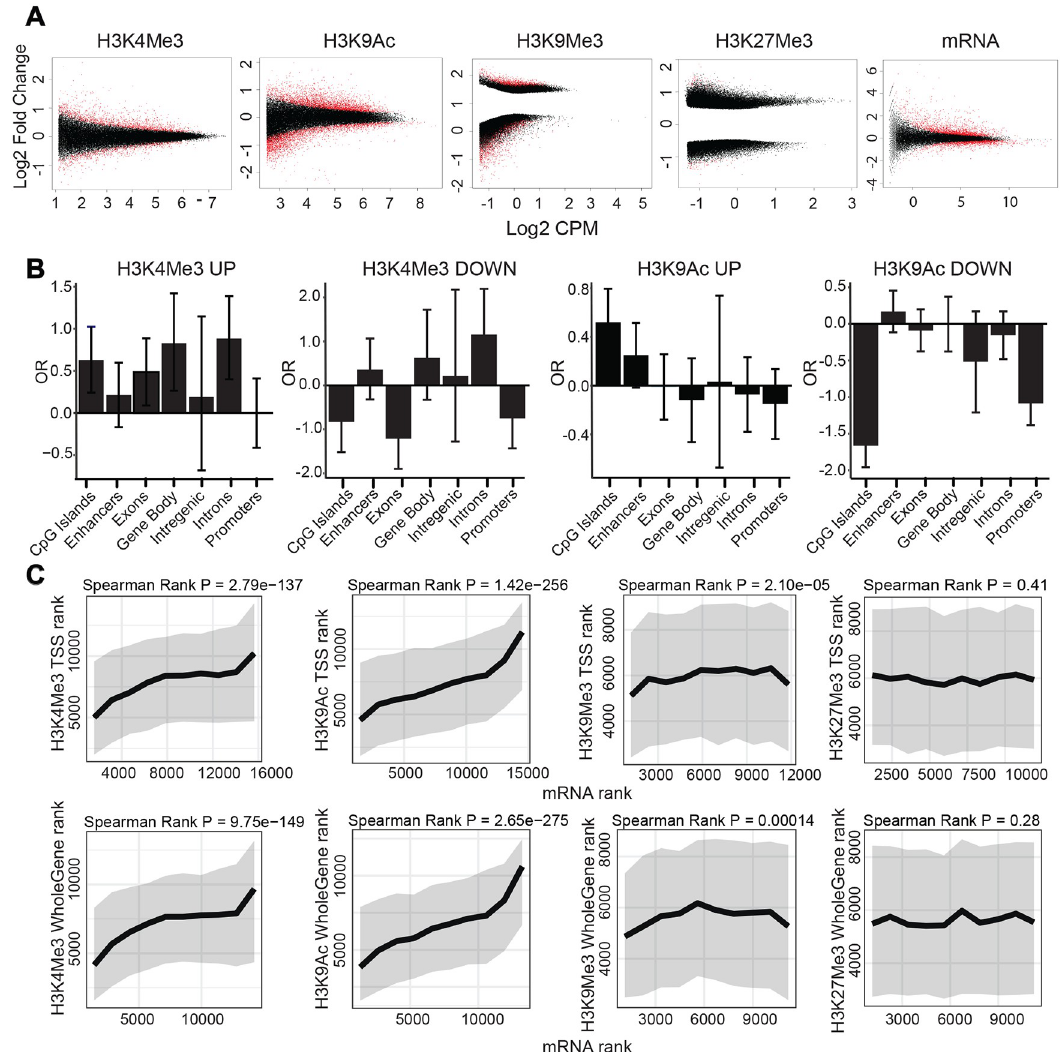
Fig 1. Differential genome-wide distribution of epigenetic markers between HCV infected vs. non-infected cells and its integration with gene expression. (A) Change in genome-wide distribution of epigenetic marks following HCV infection (100% HCV infected Huh7.5 cells, generated as described in the Methods) determined by ChIP-seq experiments, as well as change in gene expression determined by RNA-seq experiment. The plots show the number of counts per million (CPM- the log2 of the read abundance determined by edgeR) for each peak versus the log2 fold change between infected and non-infected cells for each peak. Regions subjected to significant changes are shown in red (adjusted p-value < 0.05), and nonsignificant changes are shown in black. The plots show significant changes in H3K4Me3, H3K9Ac, H3K9Me3 and mRNA expression following HCV infection in Huh7.5 cells. We identified 2,798 kbp of 1221 differential peaks for the epigenetic marker H3K4Me3 (783 up and 438 down), 7,037 kbp of 3827 differential peaks for the epigenetic marker H3K9Ac (1475 up and 2352 down) and 9,028 kbs of 9024 differential peaks for the epigenetic marker H3K9Me3 (2573 up and 6451 down) (p-value < 0.05, Log2FC � 0.5 and Log2FC � -0.5). Plots demonstrate an average of three to five biological replicates for each ChIP-seq and six biological replicates for RNA-seq experiment. (B) Enrichment of H3K4Me3 and H3K9Ac in genomic features (CpG islands, Enhancers, Exons, gene body, Intergenic, Introns and Promotors). Peaks were compared using a Fisher exact test to a background set which was generated by taking 1000 random non-significant regions (p > 0.9). Peaks were defined as p-value < 0.001 for both increased and decreased expression. The Y axis is the log2 Odds Ratio(OR). The error bars indicate 95% confidence intervals. (C) Integration of RNA-seq with H3K4Me3, H3K9Ac, H3K9Me3 and H3K27Me3 ChIP-seq data analysis. Differential mRNA rank was compared to differential ChIP-seq ranks at the TSS or whole gene regions. Ranks were calculated by signed -log10, as determined by edgeR (Ranked from most significant decrease to the most significant increase for: mRNA (x axis) vs ChIP signal (y axis)). Rank order bins of 1000 mRNA contigs each were generated. For each bin, the median (thick line) and interquartile range (grey area) are shown for the matched differential ChIP-Seq ranks. Presented are correlations calculated by Spearman rank. For each ChIP, three to five biological replicates were conducted and for RNA-seq six biological replicates were